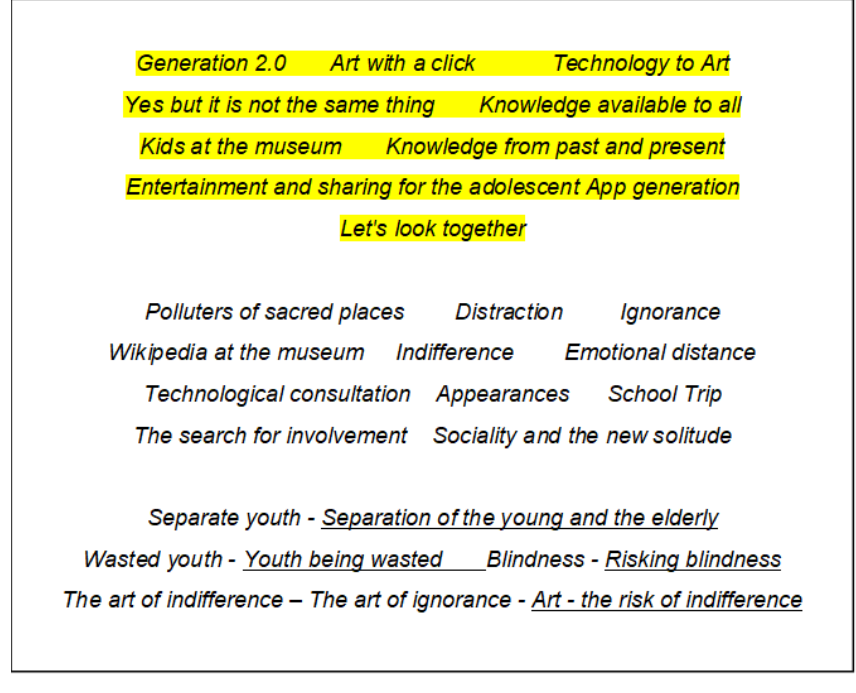
Figure 4: Confirmed and Changed Categories New - changed